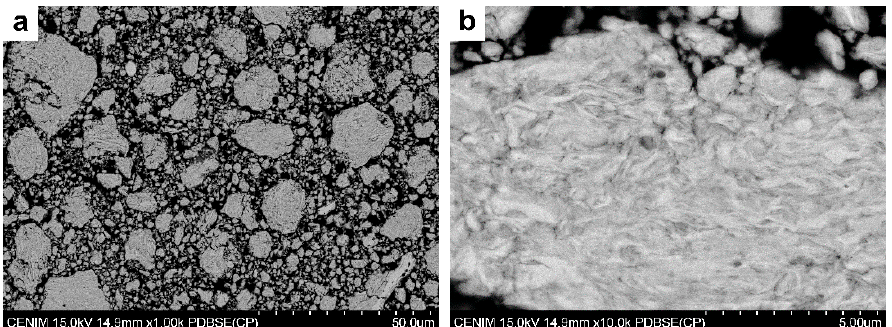
Figure 2. Cross sections of Fe5Mg powder ball milled for 16 h. Backscattered scanning electron micrographs at low ( a ), and high ( b ) magnifications.